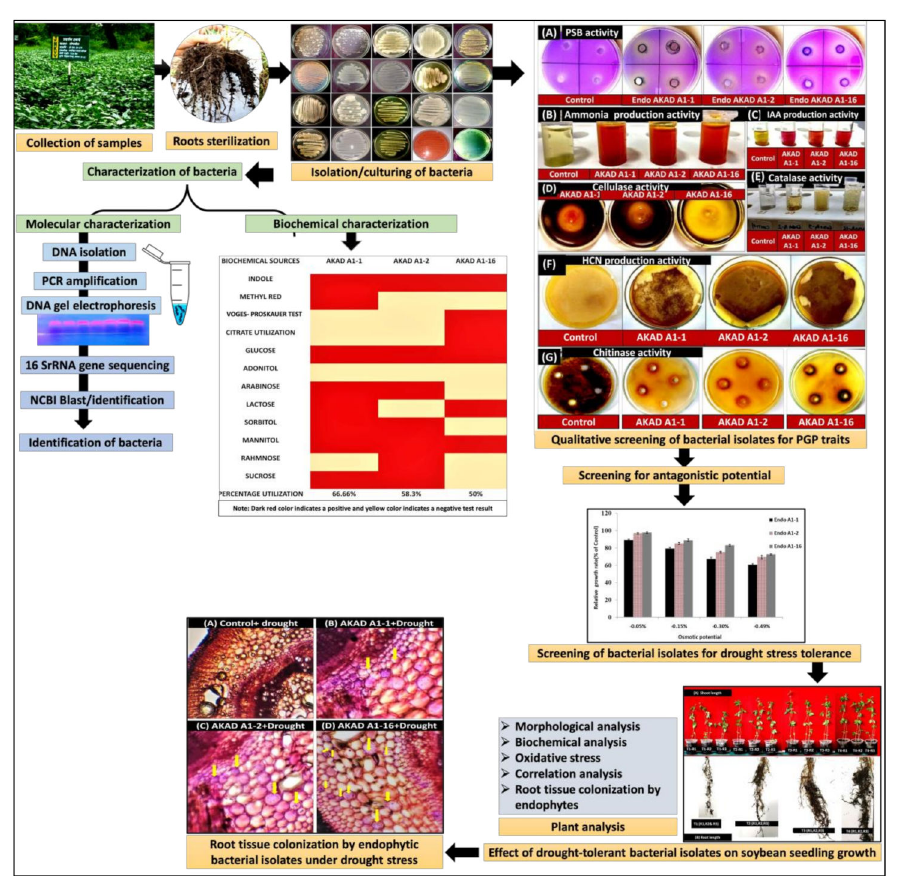
Figure 1. Flowchart of the experimental work [PSB, phosphate solubilizing bacteria; HCN, hydro- gen